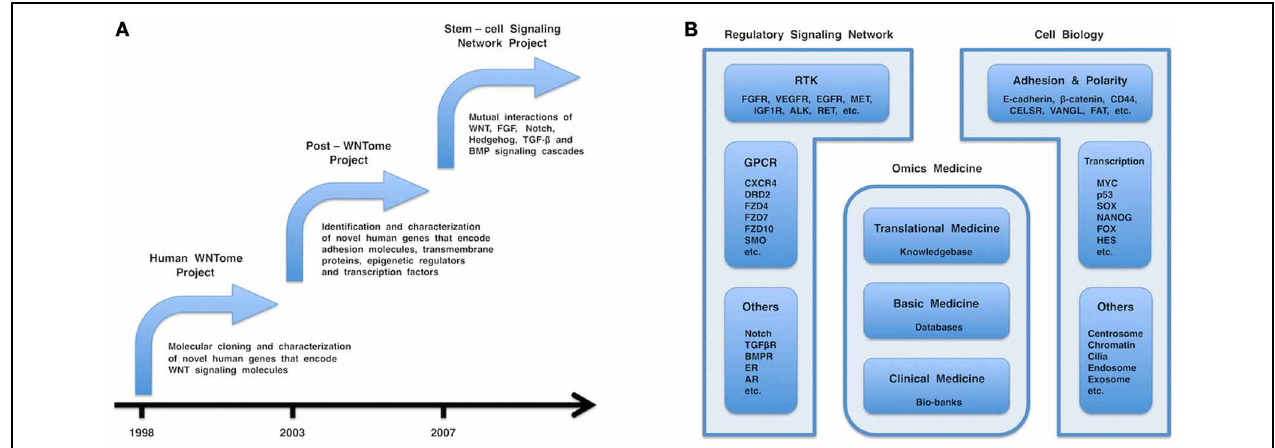
includes various important topics: cellular adhesion and polarity; centrosome biology; chromatin dynamics; endosome and exosome; and transcriptional regulation. Omics medicine consists of three layers: clinical medicine, followed by basic medicine and translational medicine. Bio-banks, databases, and a comprehensive knowledgebase are generated by clinical medicine, basic medicine, and translational medicine,